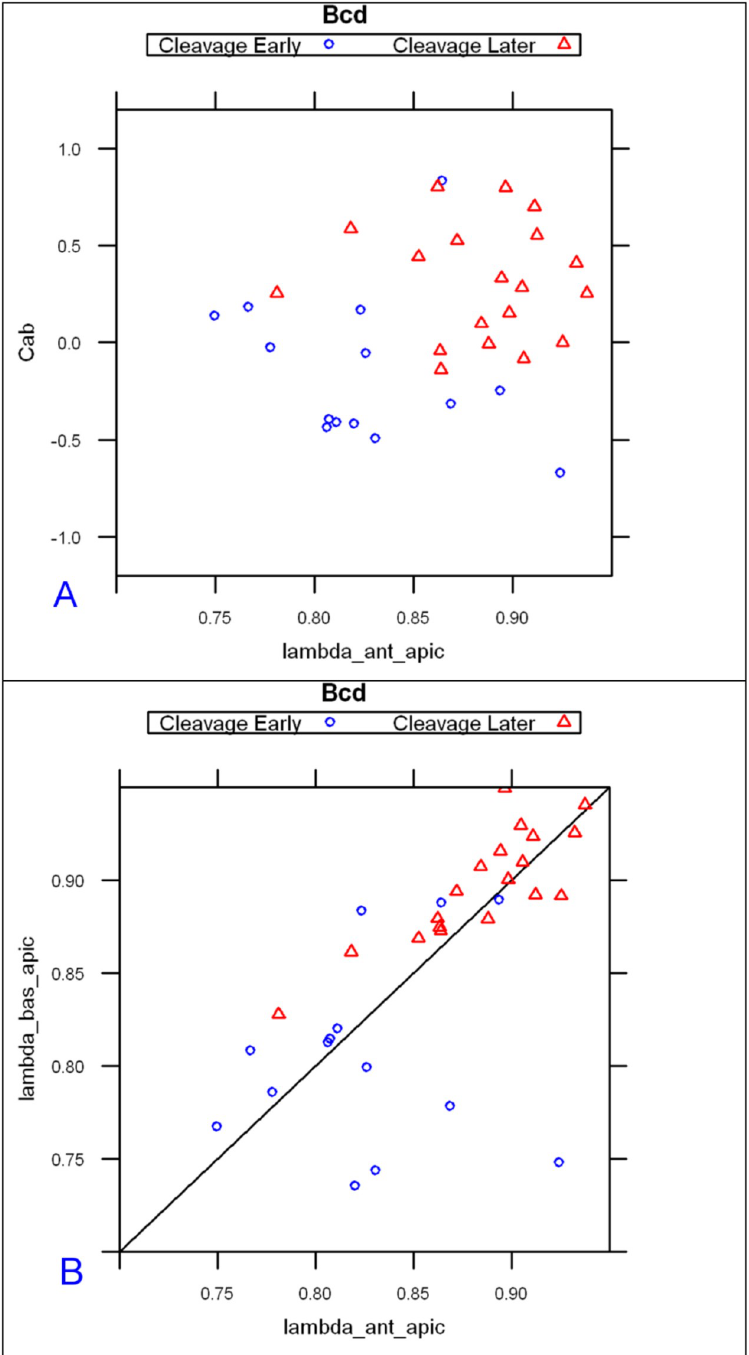
Fig 7. bcd mRNA profiles from cleavage early are clearly distinguishable from Cleavage Late in scatterplots of � � (A), and l apical ð Þ vs C ab ¼ In C apical ð Þ = C basal ð Þ vs λ ð basal Þ (B). The diagonal line in (B) is l apical ð Þ l apical ð Þ anterior anterior anterior anterior anterior fit from (10,80)